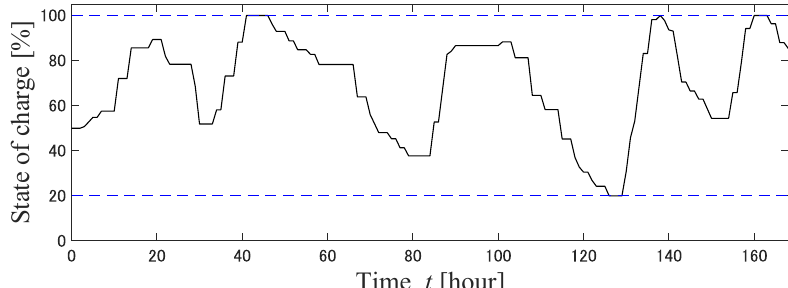
Figure 17. SOC of BESS from April 1 to 7 (Case